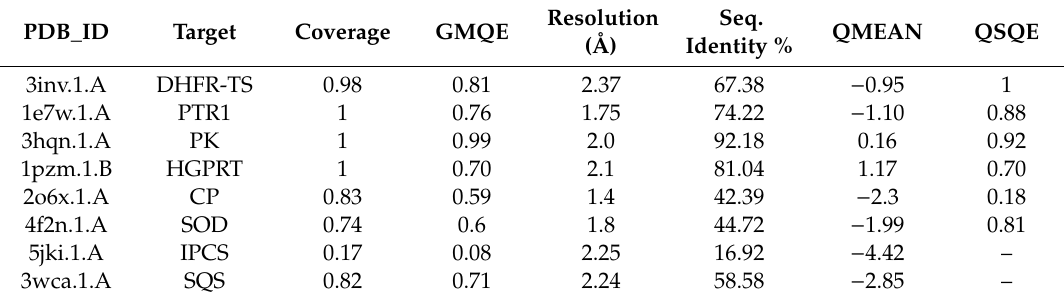
Table A2. Enzymes crystal structures available in PDB server.